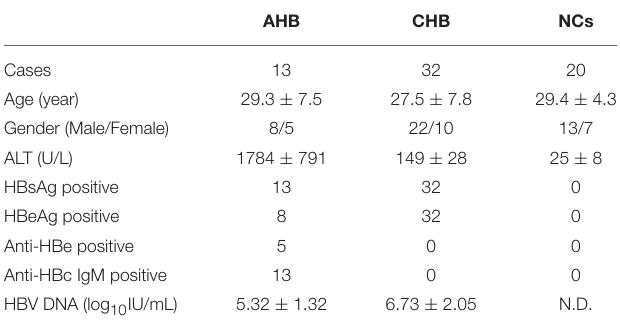
TABLE 1 | Clinical characteristics of enrolled